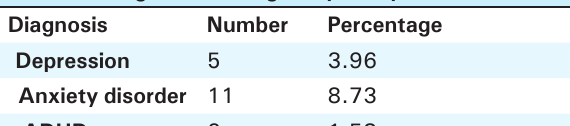
Table 5. Diagnosis among the participants